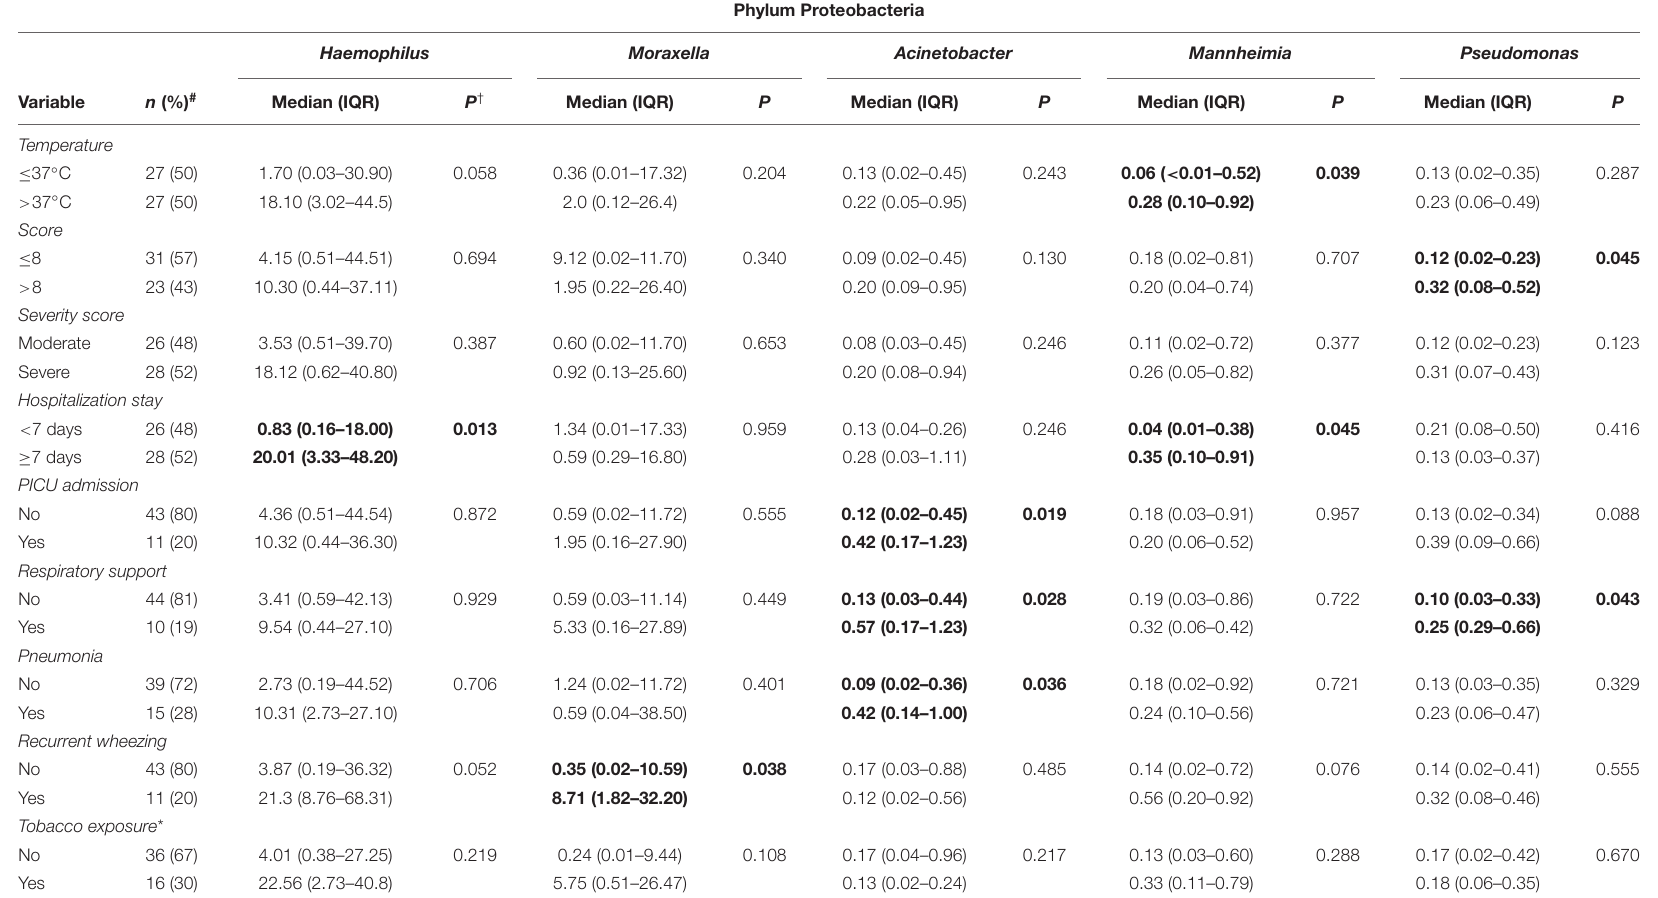
TABLE 3 | Bivariate analysis between clinical variables and the relative abundance of the main bacterial genera detected in nasal samples of infants with